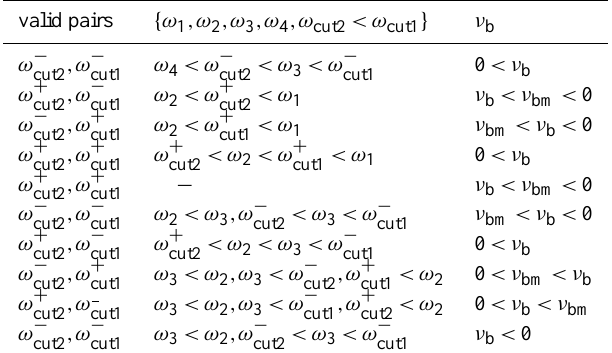
Table A1. Disposition of the ion cutoff frequencies ω cut2 and ω cut1 with respect to the gyrofrequencies ω 1 and ω 2 (resp. ω 3 and ω 4 ) of the positively (resp. negatively) charged light ions. In the last column the relative charge density ν b of the IPB is compared with the critical charge density ν bm corresponding to ω cut1 = ω cut2